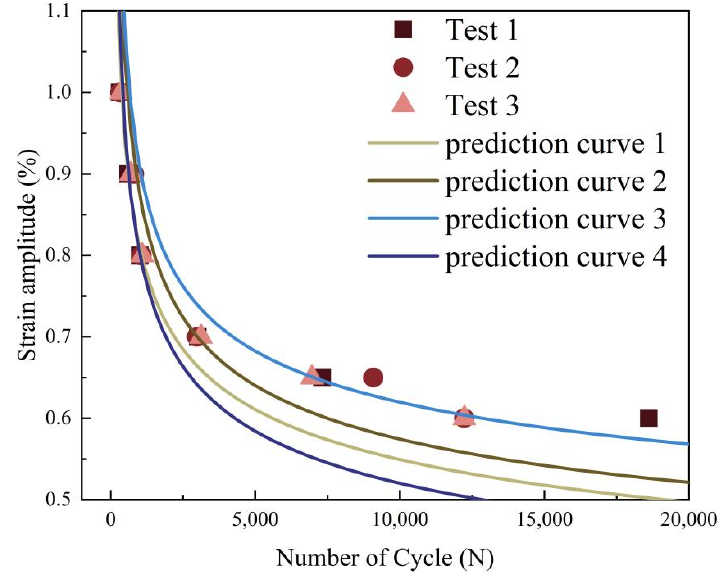
Figure 8. LCF predicted curves from the four prediction methods of TC21 IFW joints.